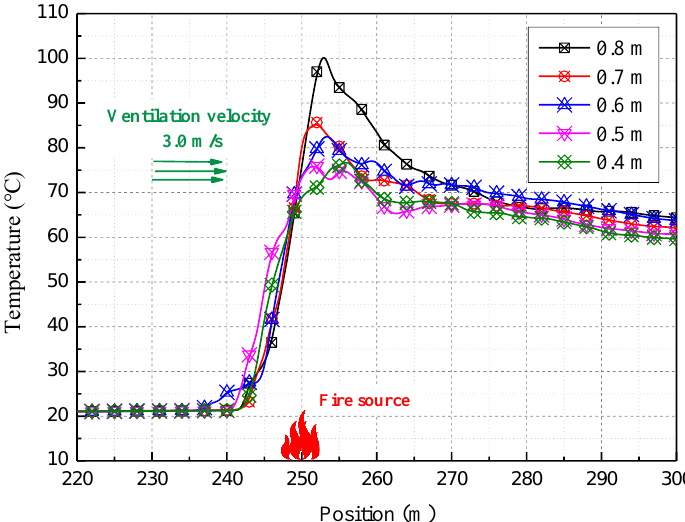
Figure 2. Temperature distribution with different grid sizes.